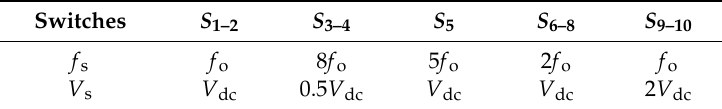
Table 3. Voltage stress and frequency of